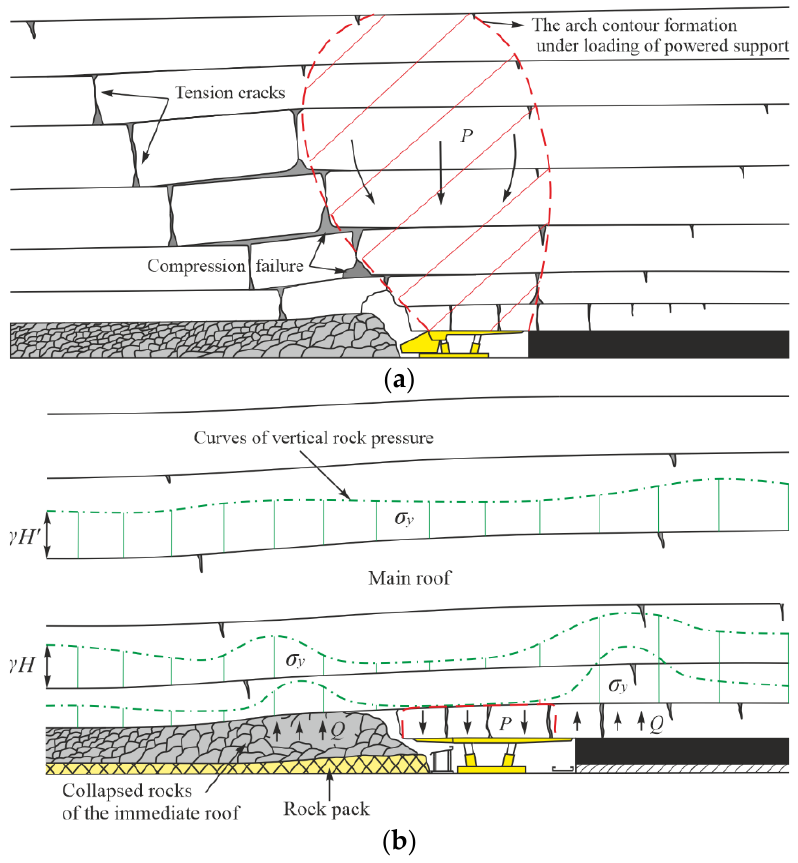
Figure 2. Rock displacements in the coal-overlaying formation: ( a ) Known scheme of traditional technology with complete caving of the roof rocks; ( b ) Expected rock mass behavior at selective seam mining with leaving the undercut rocks in the mined ‐ out space.